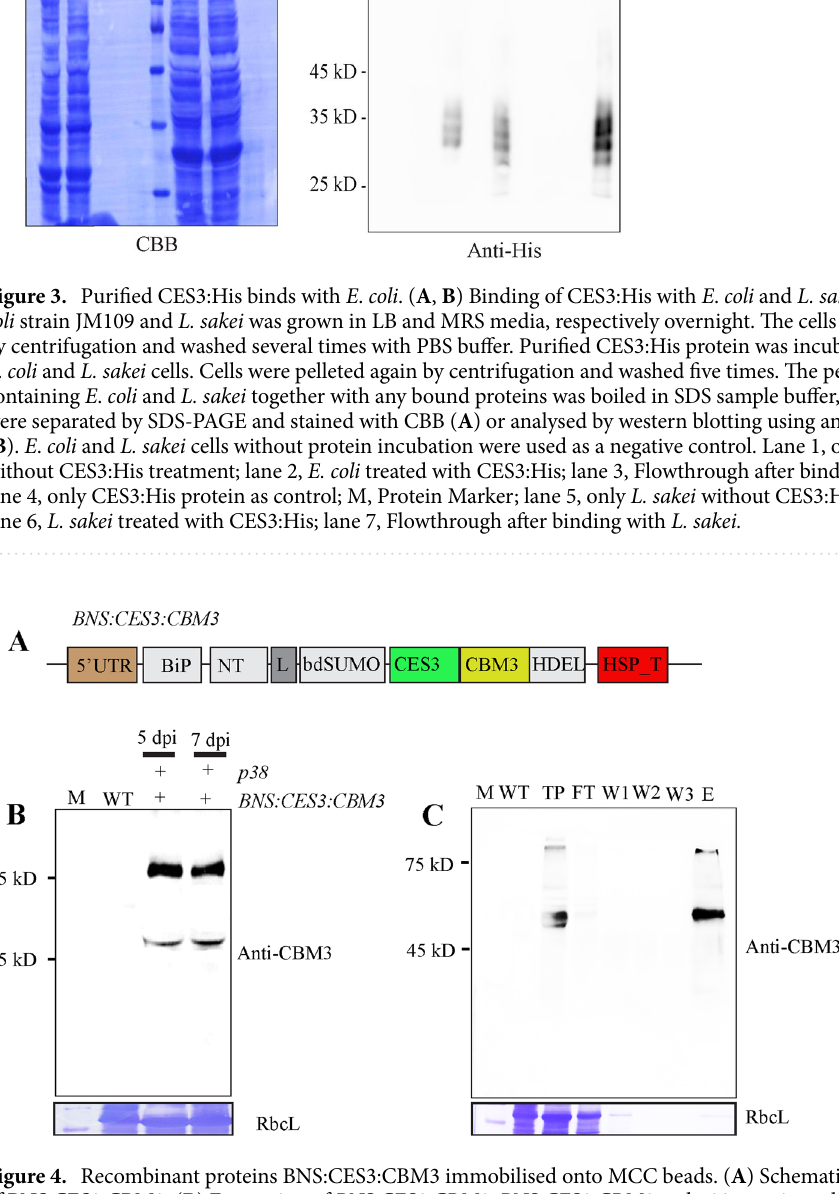
Figure 4. Recombinant proteins BNS:CES3:CBM3 immobilised onto MCC beads. ( A ) Schematic presentation of BNS:CES3:CBM3. ( B ) Expression of BNS:CES3:CBM3 . BNS:CES3:CBM3 and p38 were introduced into N . benthamiana leaf tissues via Agrobacterium -mediated infiltration. Total protein extracts were prepared from leaf tissues harvested at 5 and 7 dpi and analysed by western blotting using anti-CBM3 antibody (upper panel). The membrane was stained with CBB, and RbcL was used as loading control (bottom panel). ( C ) Binding of BNS:CES3:CBM3 to MCC beads. Total protein extracts were incubated with prewashed MCC beads for 1 h. Beads were pelleted, washed, and boiled in 1X loading buffer. Proteins were separated by SDS-PAGE and analysed by western blotting using anti-CBM3 antibody. WT, non-transformed plants; FT, flow-through; W1-3, washing-off 1–3; E, MCC beads-bounded